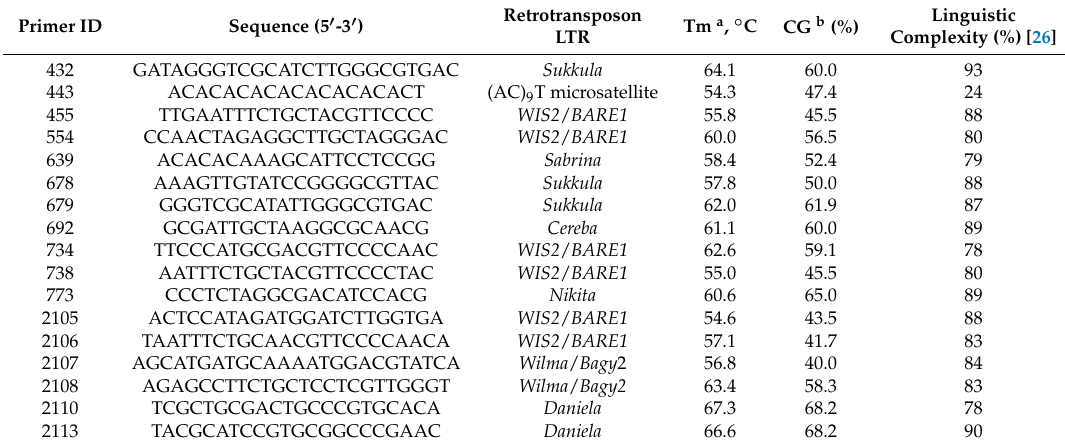
Table 2. Primers used for IRAP and